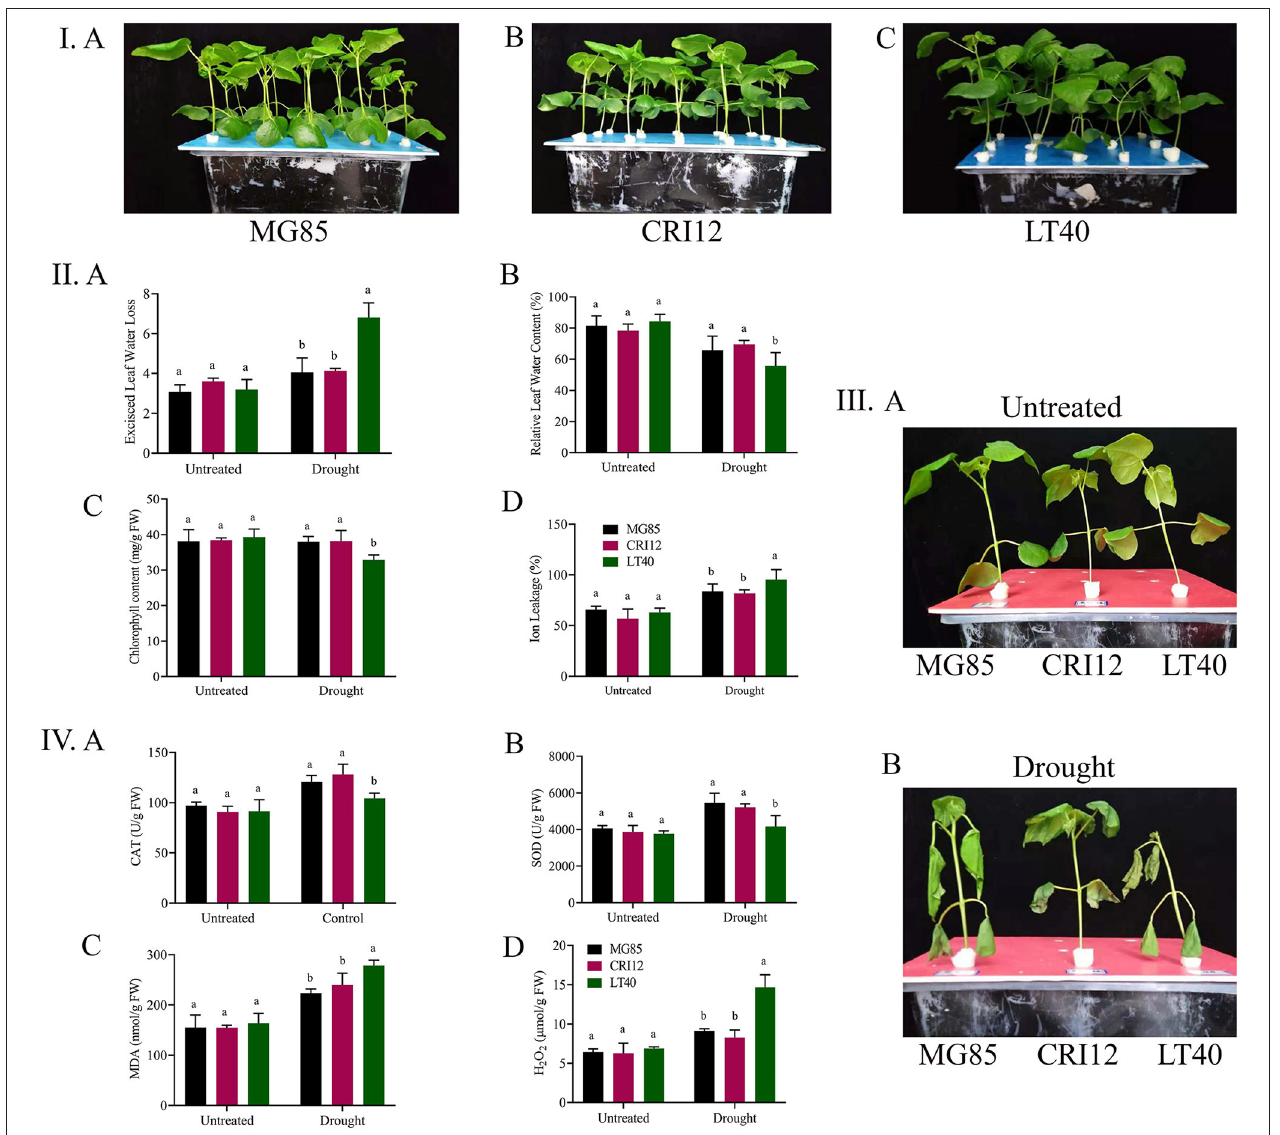
FIGURE 1 | Cotton physiological and biochemical parameters determination. (I) A Marie-galantie85, B Upland cotton, C Lattifolium40. (II) Phenotype parameters evaluation, A Excised leaf water loss, B Relative leaf water content, C Chlorophyll content, D Cell membrane stability. (III) A Representative images of Marie-galantie85, Upland cotton, and Lattifolium40 before treatment B Representative images of (Marie-galantie85, Upland cotton, and Lattifolium40) after Drought treatment. (IV) A Catalase, B Super oxidase, C Malondehyde, D Hydrogen peroxide. SE is reflected by error bars. Using the Least Significance Difference (LSD) means on the same graph tracked by the same letter are not statistically different at the 5% probability level, Drought: supplementing with 17% PEG-6000 solution.